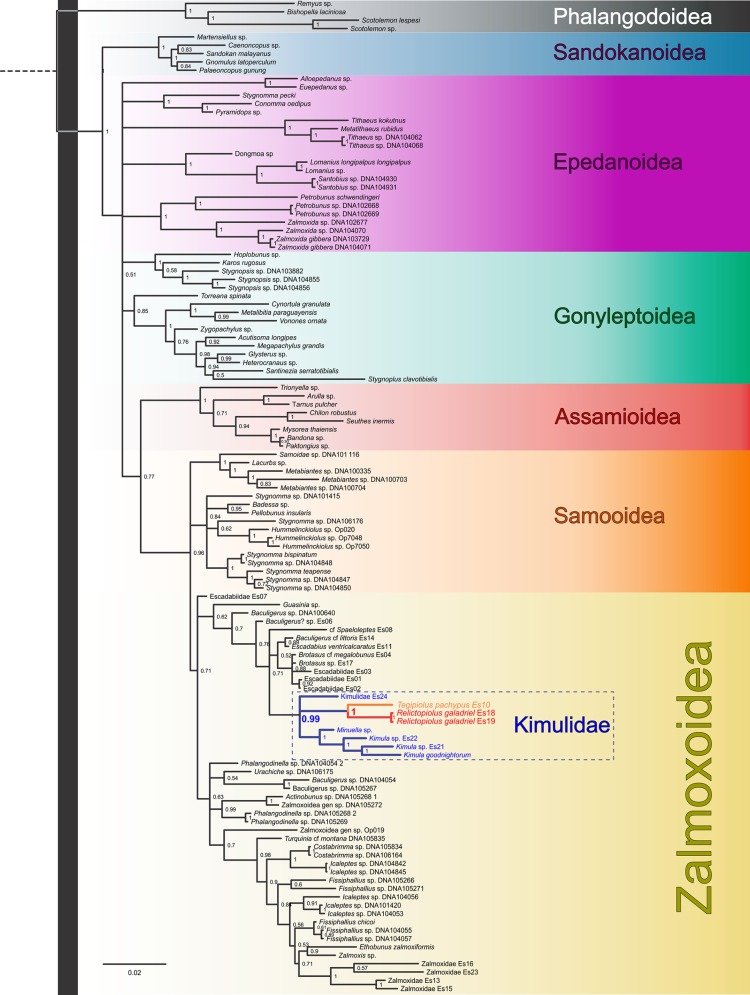
Phylogram of Grassatores obtained by Bayesian inference analysis, conducted in MrBayes, using the complete concatenated dataset.Support values at nodes represent posterior probabilities (PP). Nodes with PP<0.50 are collapsed. Colors represent the current superfamilial divisions (sensu Fernandez et al. [35]). The monophyletic family Kimulidae is enclosed in a box.